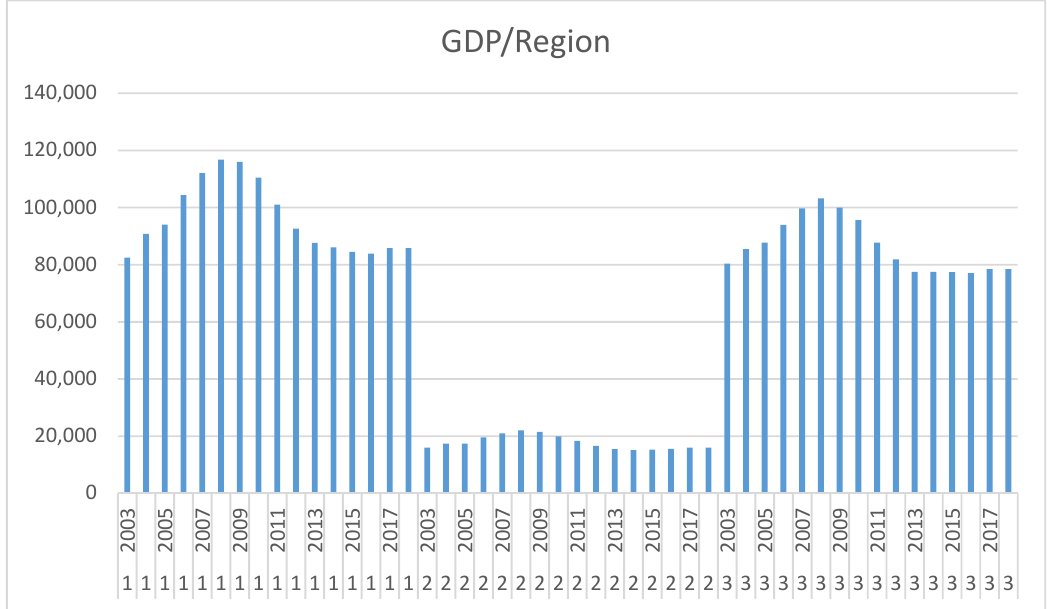
Figure 2. Deposits in mil. euros per region/year (2003–2018). Source of data: Bank of Greece.